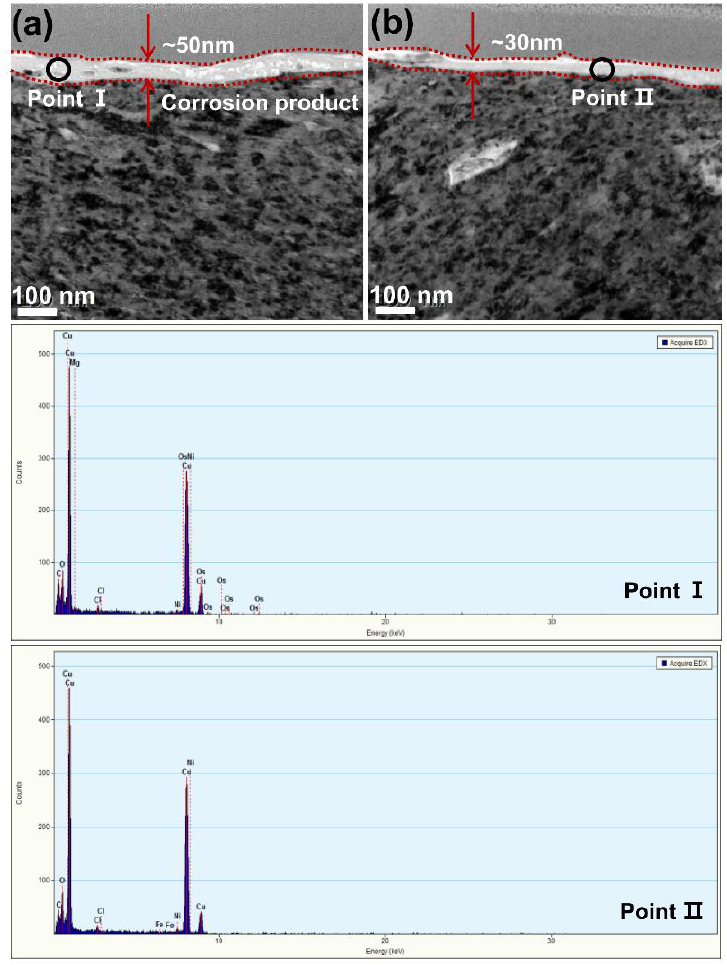
Figure 10. TEM images of the Monel 400 alloy and the chemical composition of corrosion product’s layer after tribo-corrosion tests at ( a ) 0.125 m/s and ( b ) 0.5 m/s.